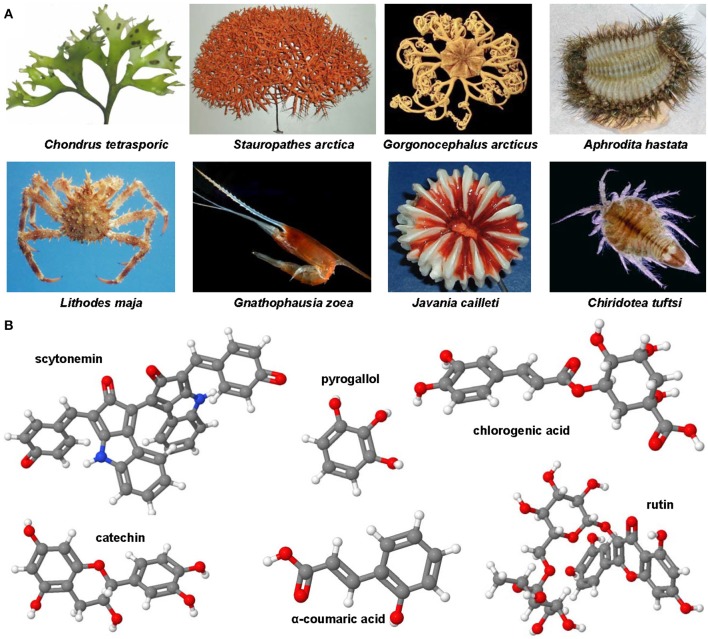
Bioactive compounds derived from marine organisms. (A) There is a large variety of organisms that may serve as a biological source for anti-fibrotic compounds. (B) Scytonemin (CAS 152075-98-4), pyrogallol (CAS 87-66-1), chlorogenic acid (CAS 327-97-9), catechin, (CAS 154-23-4), α-coumaric acid (CAS 614-60-8), and rutin (CAS 153-18-4) are substances with different structures, that however have similar anti-inflammatory and anti-fibrotic activities. The individual figures in (A) were published with the kind permission of Mr. Claude Nozères, Government of Canada, Department of Fisheries and Oceans (www.marinespecies.org/carms/photogallery.php).